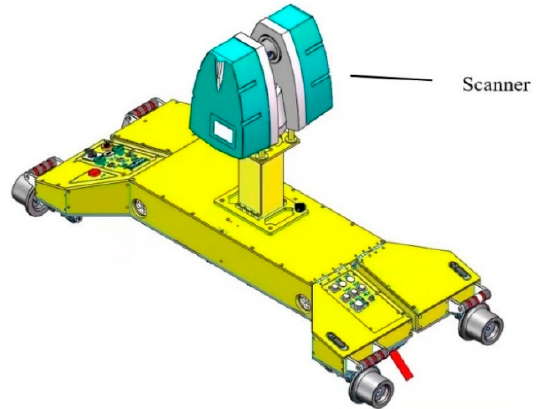
Figure 1. Schematic diagram of the mobile tunnel inspection vehicle.